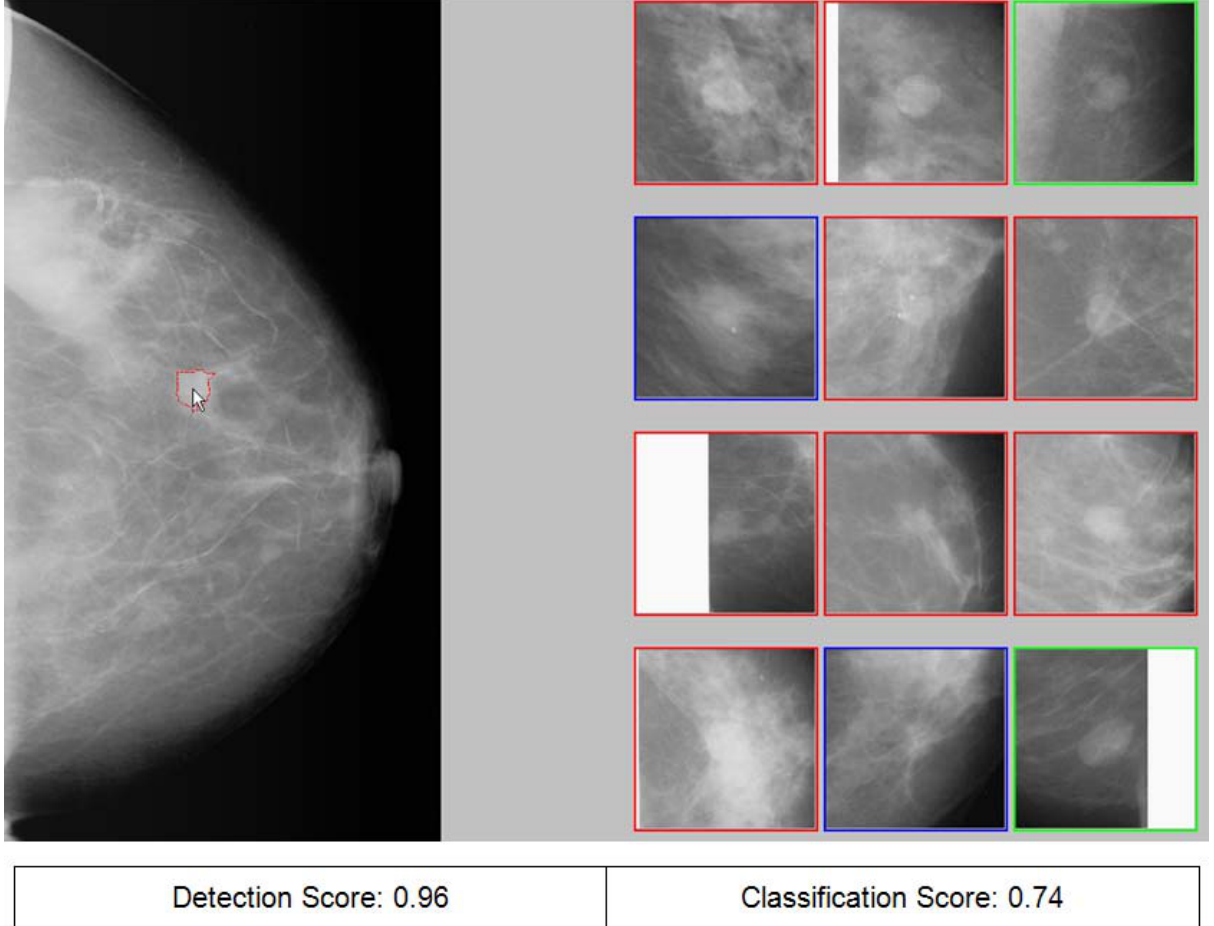
Figure 2: Example of applying a CAD scheme using CBIR approach to detect and classify a suspicious breast mass region. A suspicious mass is automatically detected by CAD scheme and queried by the observer (pointed by the arrow). In CAD workstation, the mass region segmentation (boundary contour), 12 CBIR-selected similar ROIs, and both detection and classification scores are displayed. Among the 12 similar ROIs, 8 depict malignant masses (marked by Red frame), 2 depict benign masses (marked by Green frame), and 2 depict CAD-cued false-positive regions (marked by Blue